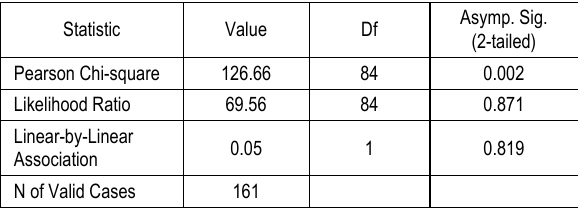
Table 2. Chi-square test for age in years versus